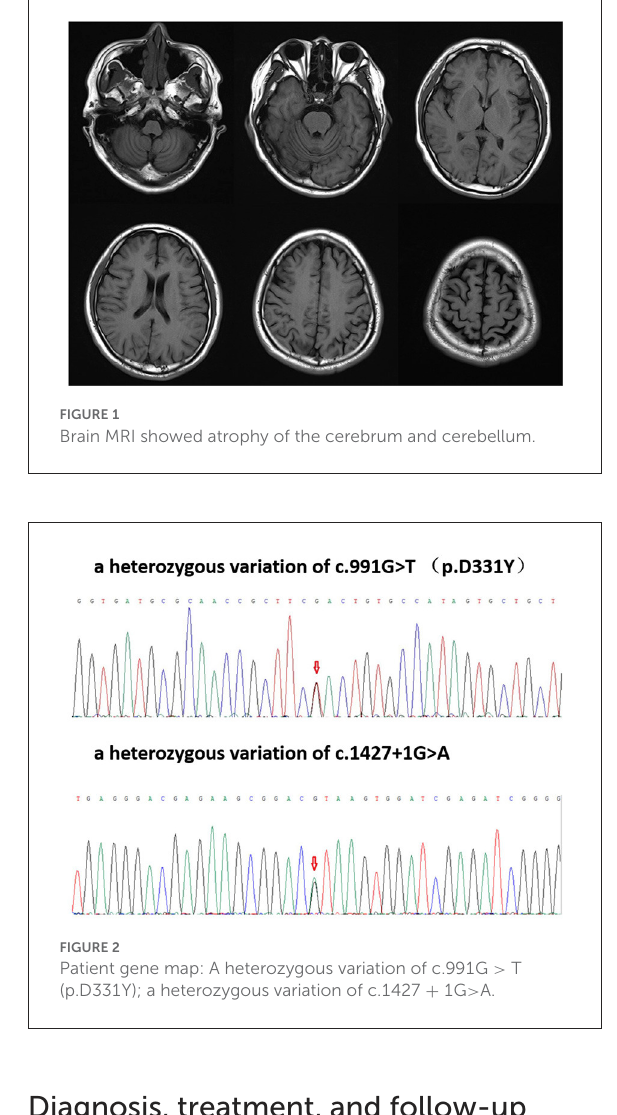
Diagnosis, treatment, and